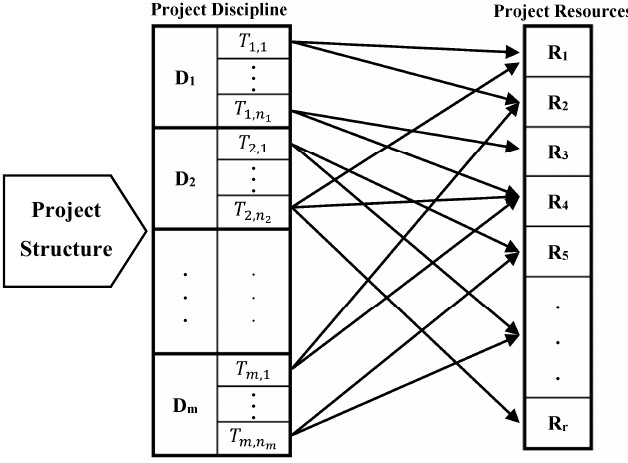
Figure 3. Project disciplines and their relations to project resources.